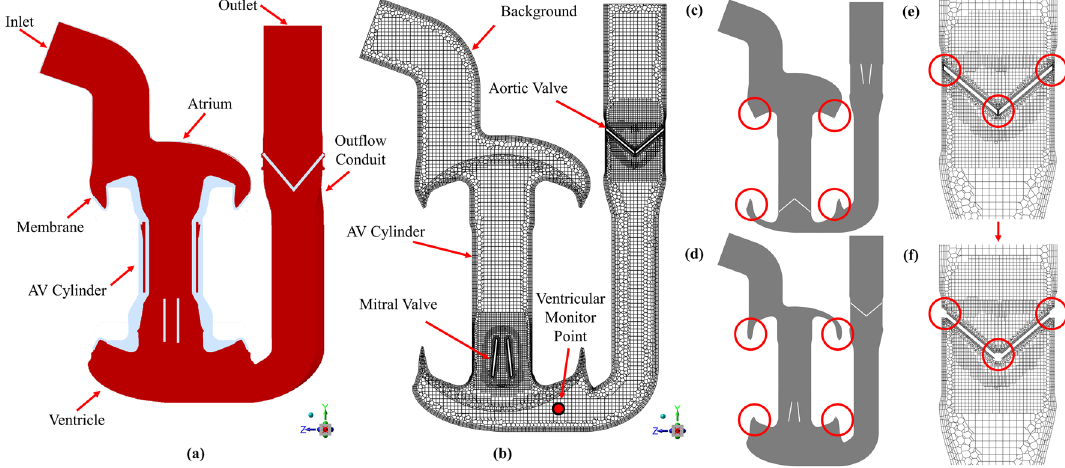
Figure 1. Computational domain and mesh of the Realheart TAH CFD model, showing ( a ) schematic of the TAH, with locations of the inlet and outlet, outflow conduit, atrial and ventricle regions alongside connective membrane linking the translating AV cylinder to these regions. ( b ) The internal mesh and the locations of the six overset component zones: background, AV cylinder, two mitral leaflets and two aortic leaflets. ( c ) Shape of the overlap between AV cylinder and atria and ventricle (circled in red) at end systole and ( d ) end diastole. ( e ) Locations of the small peripheral gaps (circled in red) that become excluded due to the gap model at ( f )